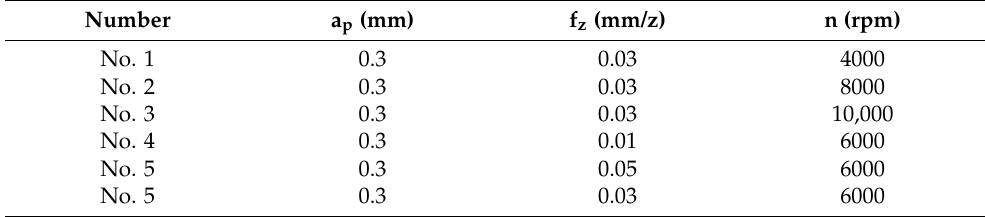
Table 2. Several groups of cutting